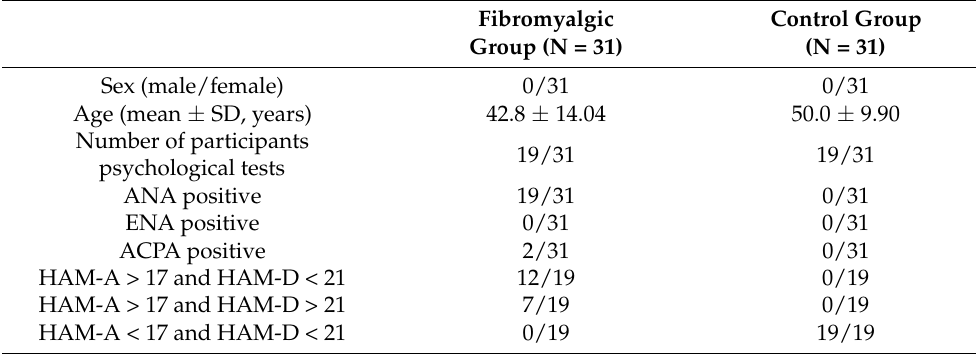
Table 3. Demographic and clinical information related to fibromyalgia patients and